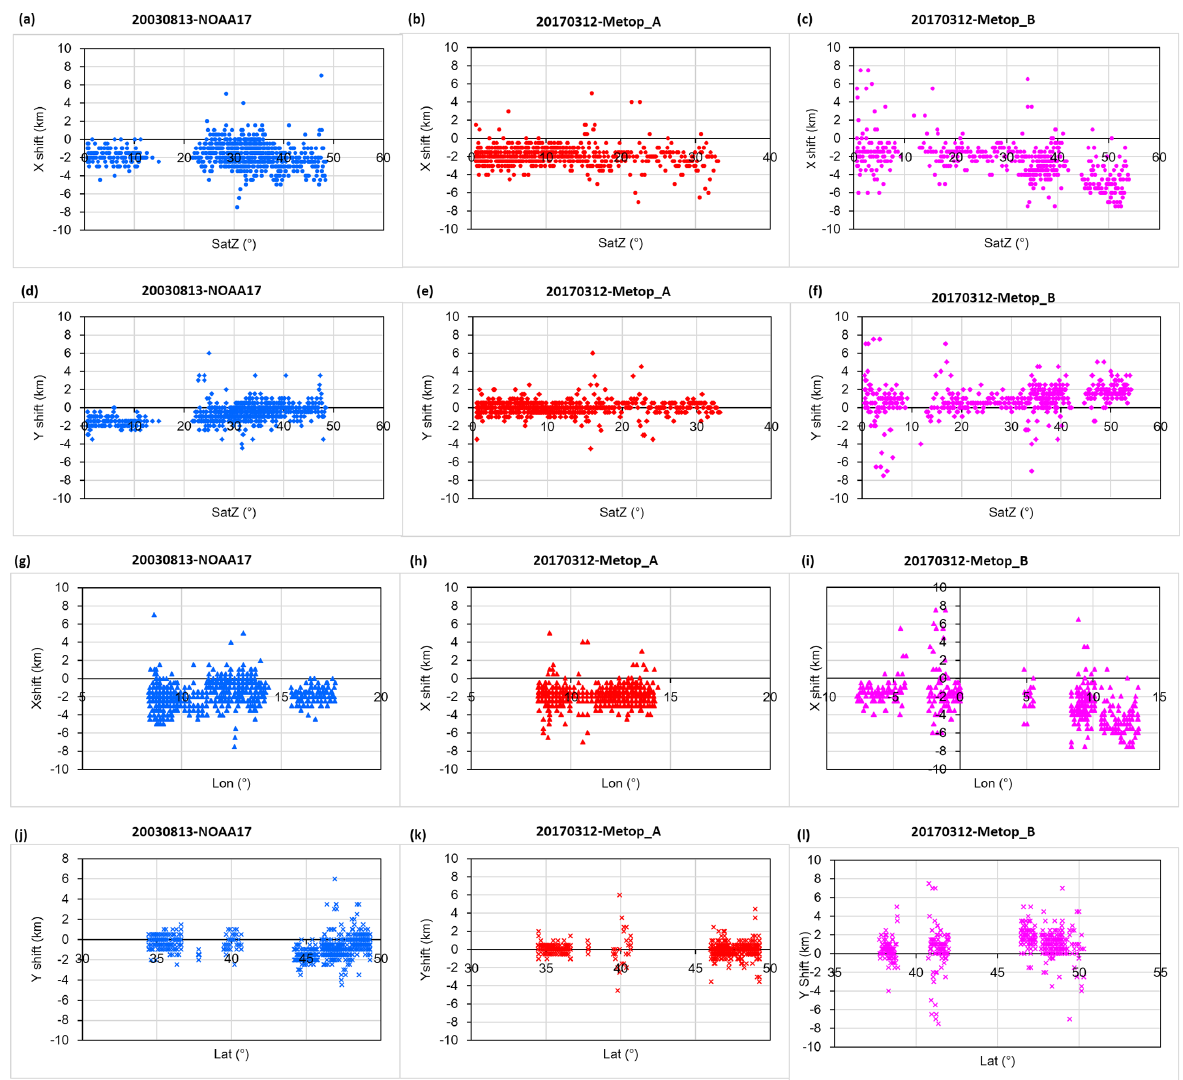
Figure 8. Influence of SatZ on the geolocation accuracy in the across-track (a–c) and along-track (d–f) directions. Panels (g–i) and (j–l) describe the influence of longitude and latitude on the geolocation accuracy in the across-track and along-track directions, respectively. The left column indicates results of NOAA-17 (blue), middle MetOp-A (red) and right MetOp-B (pink)